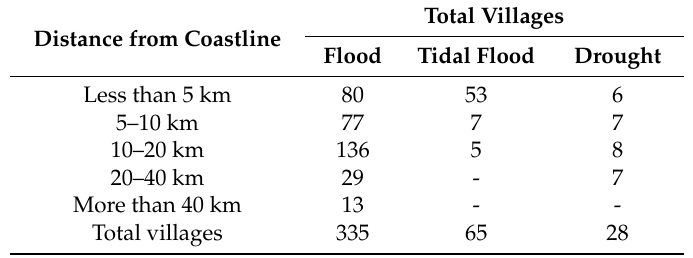
Table 6. Different climate-related disasters distributed along the northern coastal area in 2010. Distance from Coastline